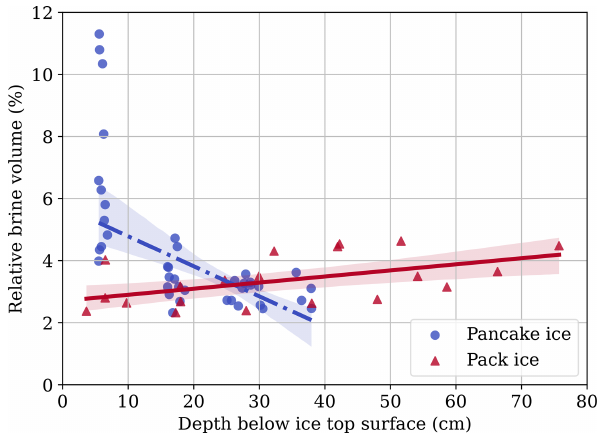
Figure 11. Brine volume for a uniform ice temperature of − 10 ◦ C as a percentage of the total volume as a function of depth for pancake ice floes ( r = − 0 . 658, n = 40, p < 0 . 001) and consoli- dated pack ice ( r = 0 . 508, n = 20, p = 0 . 022) at stations MIZ1D and MIZ3A, respectively. The shading indicates the 90th-percentile confidence intervals.